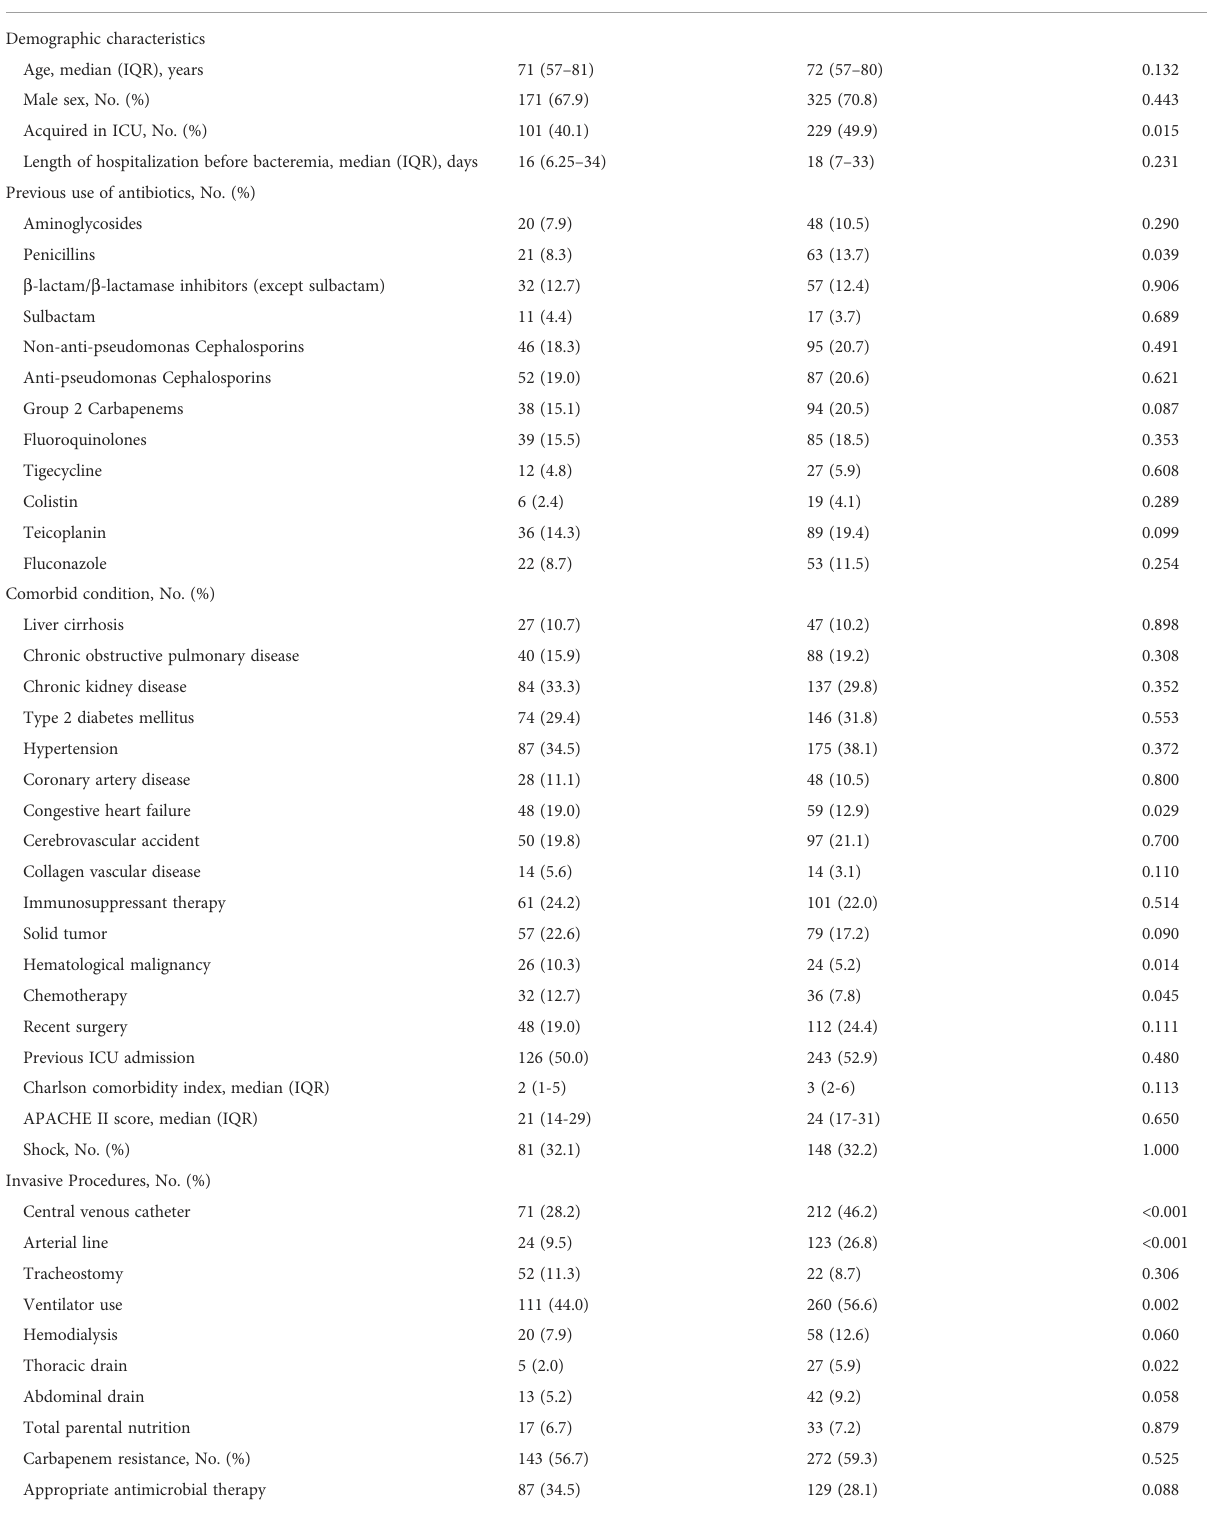
TABLE 3 Clinical characteristics of patients and clinical isolates with bio fi lm-forming and non-bio fi lm-forming Acinetobacter baumannii blood stream infections. Bio fi lm-forming ( n =